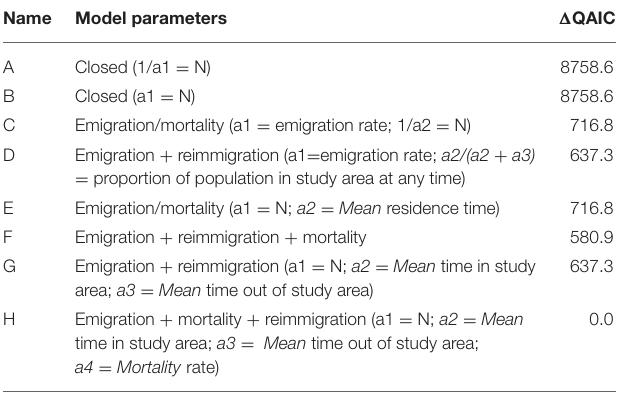
TABLE 2 | Models run for Lagged Identification Rate at Donsol.